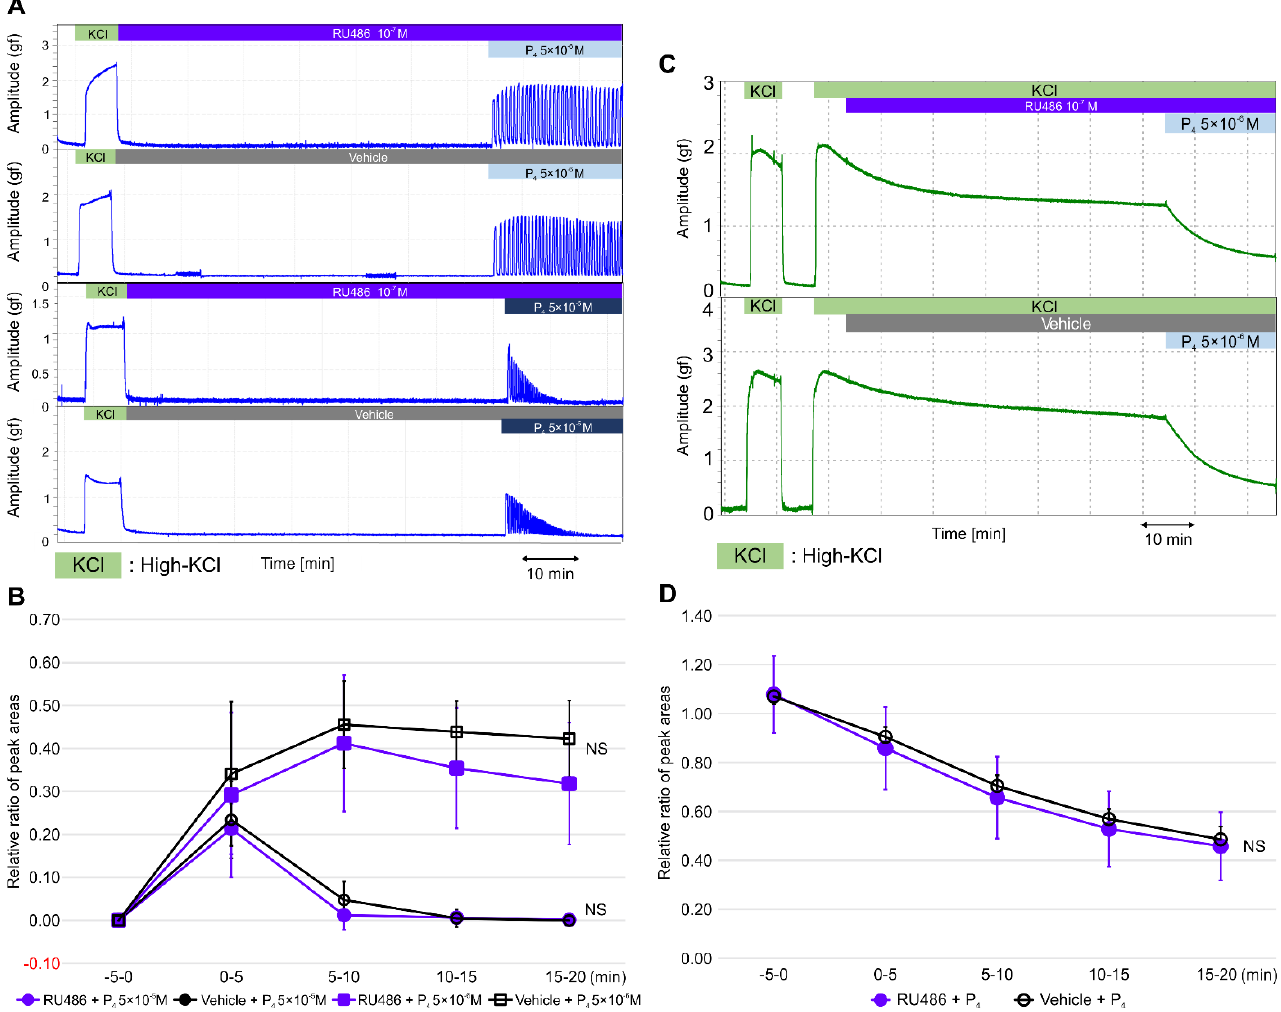
Figure 3. Effects of RU486 on progesterone-induced contractions in the resting myometrium and on progesterone-induced inhibitions against high-KCl-induced contractions. ( A ) Representative myograph of six myographs was obtained when the resting myometrial strips were pretreated with RU486 (10 −7 M) or a vehicle for 60 min, progesterone was added at 5 × 10 −6 or 5 × 10 −5 M, and myometrial strips were cotreated with RU486 or a vehicle for 20 min. ( B ) Time-dependent changes in the relative ratio of the peak area (RRPA) of progesterone-induced contractions in the RU486- and vehicle-treated groups. ( C ) Representative myograph of six myographs obtained when myometrial strips contracted by high KCl were pretreated with RU486 or a vehicle for 60 min, progesterone was added at 5 × 10 −6 M, and the strips were cotreated with RU486 or a vehicle for 20 min. ( D ) Time-dependent changes in the RRPA of high-KCl-induced contractions in the RU486- and vehicle-treated progesterone